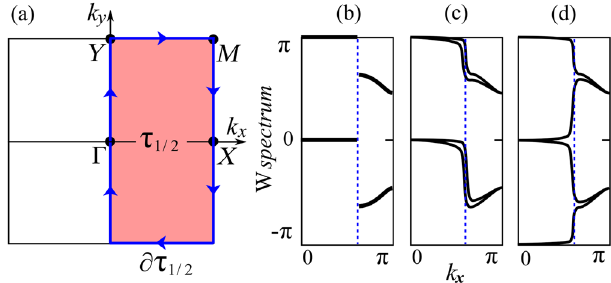
FIG. 5. (b) – (d) Pictorial argument for a quantum spin Hall phase, given a metal with a single Dirac fermion (per spin component) in τ 1 [red shaded half-Brillouin zone in = 2